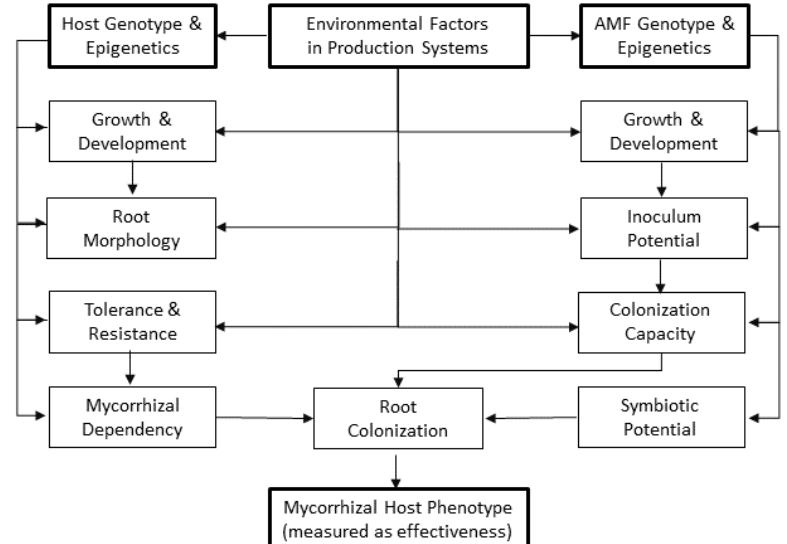
Fig. 5: Mycorrhizal effectiveness as phenotype of host/AMF interactions and population biological measures (after F eLDmann ,